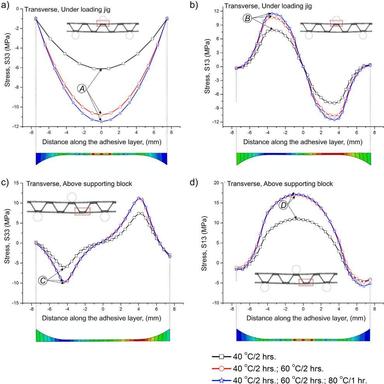
Stress distribution in the adhesive overlap and fillets of the ABCSS under transverse loading: a) normal and b) shear stresses under loading jig; a) normal and b) shear stresses above supporting block, with marks A, B, C, D indicating the corresponding peak stress locations.